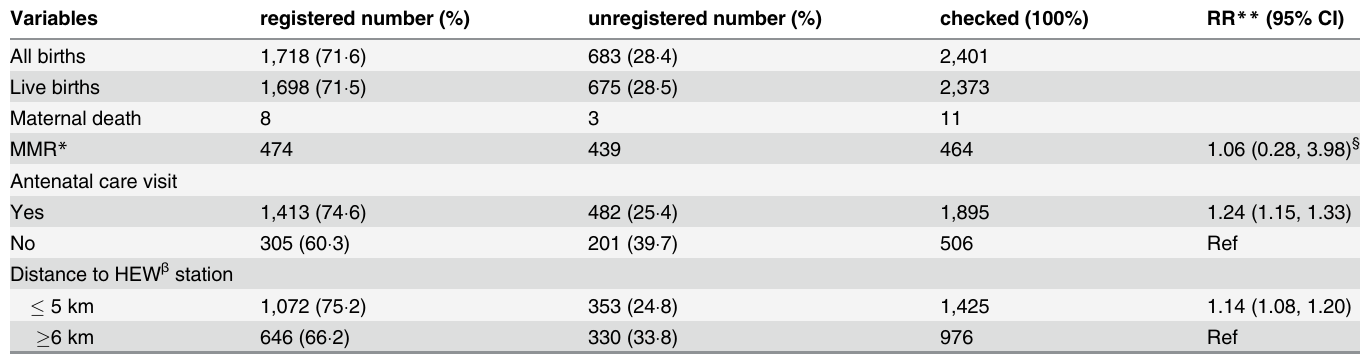
Table 4. Results from house-to-house validation study to check completeness of birth registry in south Ethiopia during 2010.